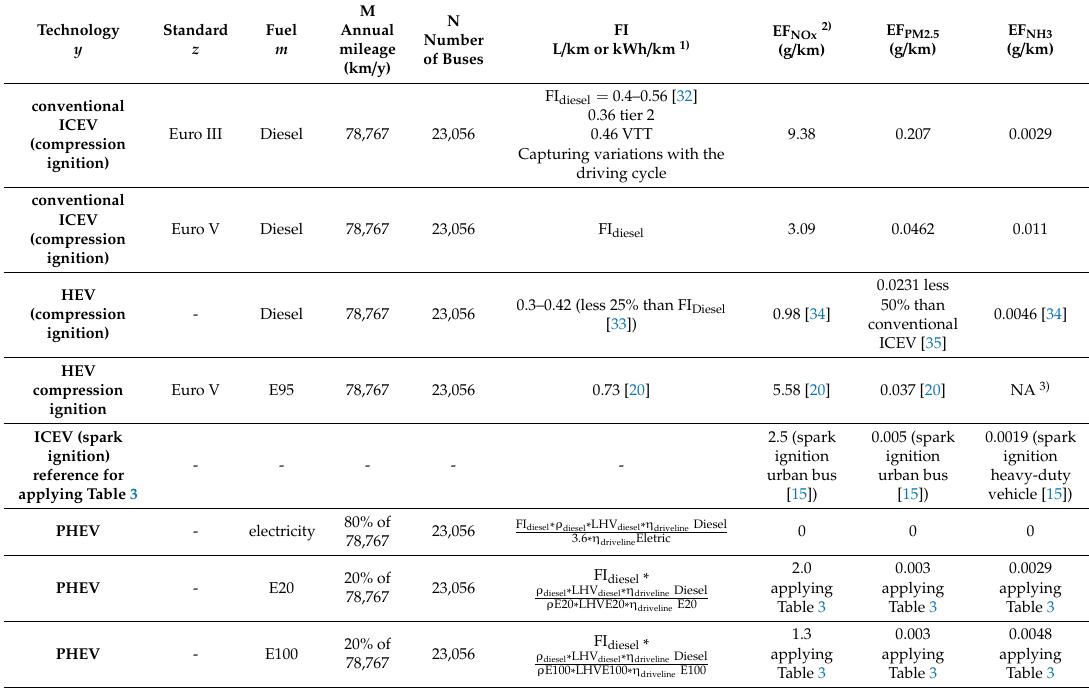
Table 7. Inputs for fuel consumption and emissions